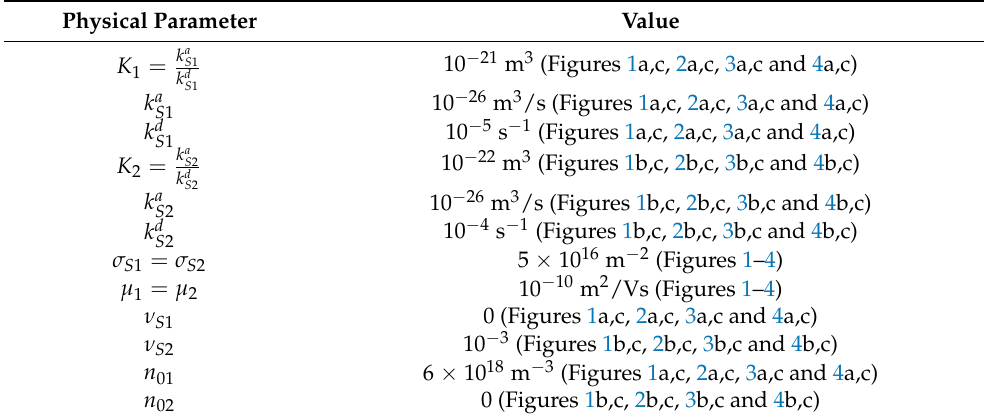
Table 1. Physical parameters and their values. Physical